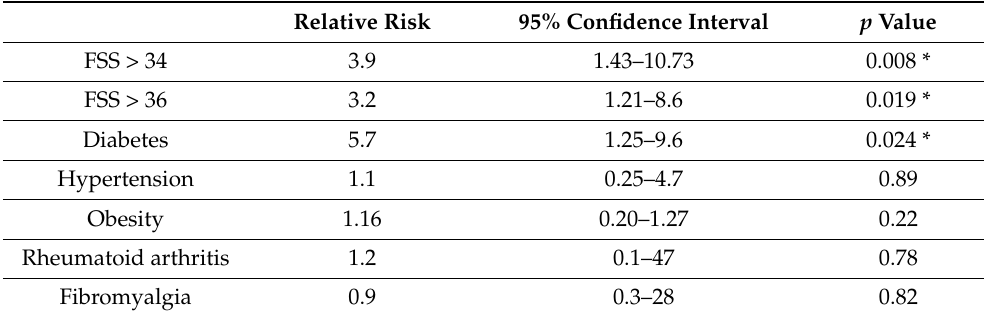
Table 6. Risk factors associated with persistence of fatigue after 6 months of levothyroxine replace- ment